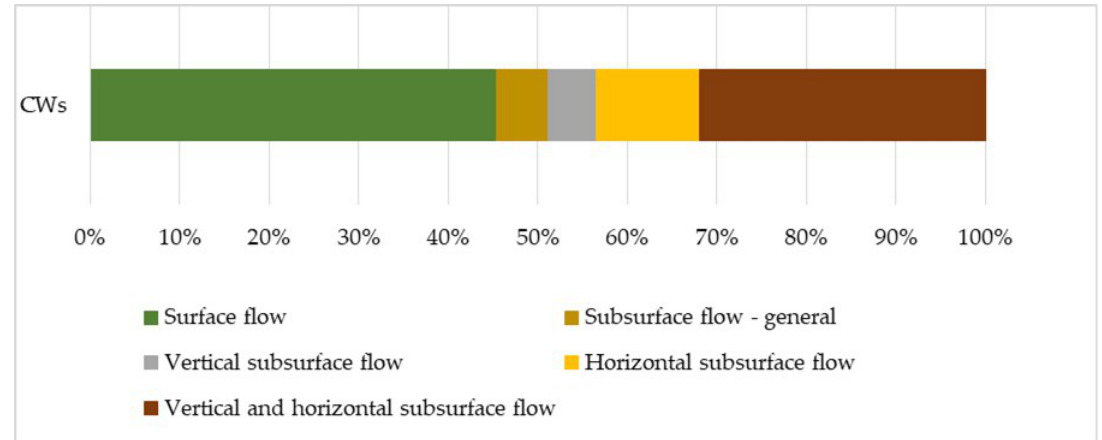
Figure 8. Percentage rate of articles, from 1995 to 2020, about constructed wetlands with common reed.